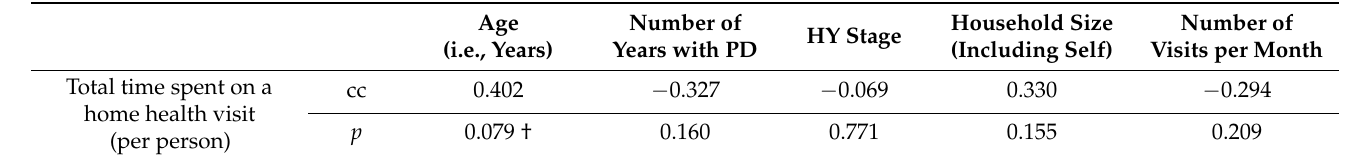
Table 3. Correlations between nursing care time and patient characteristics.